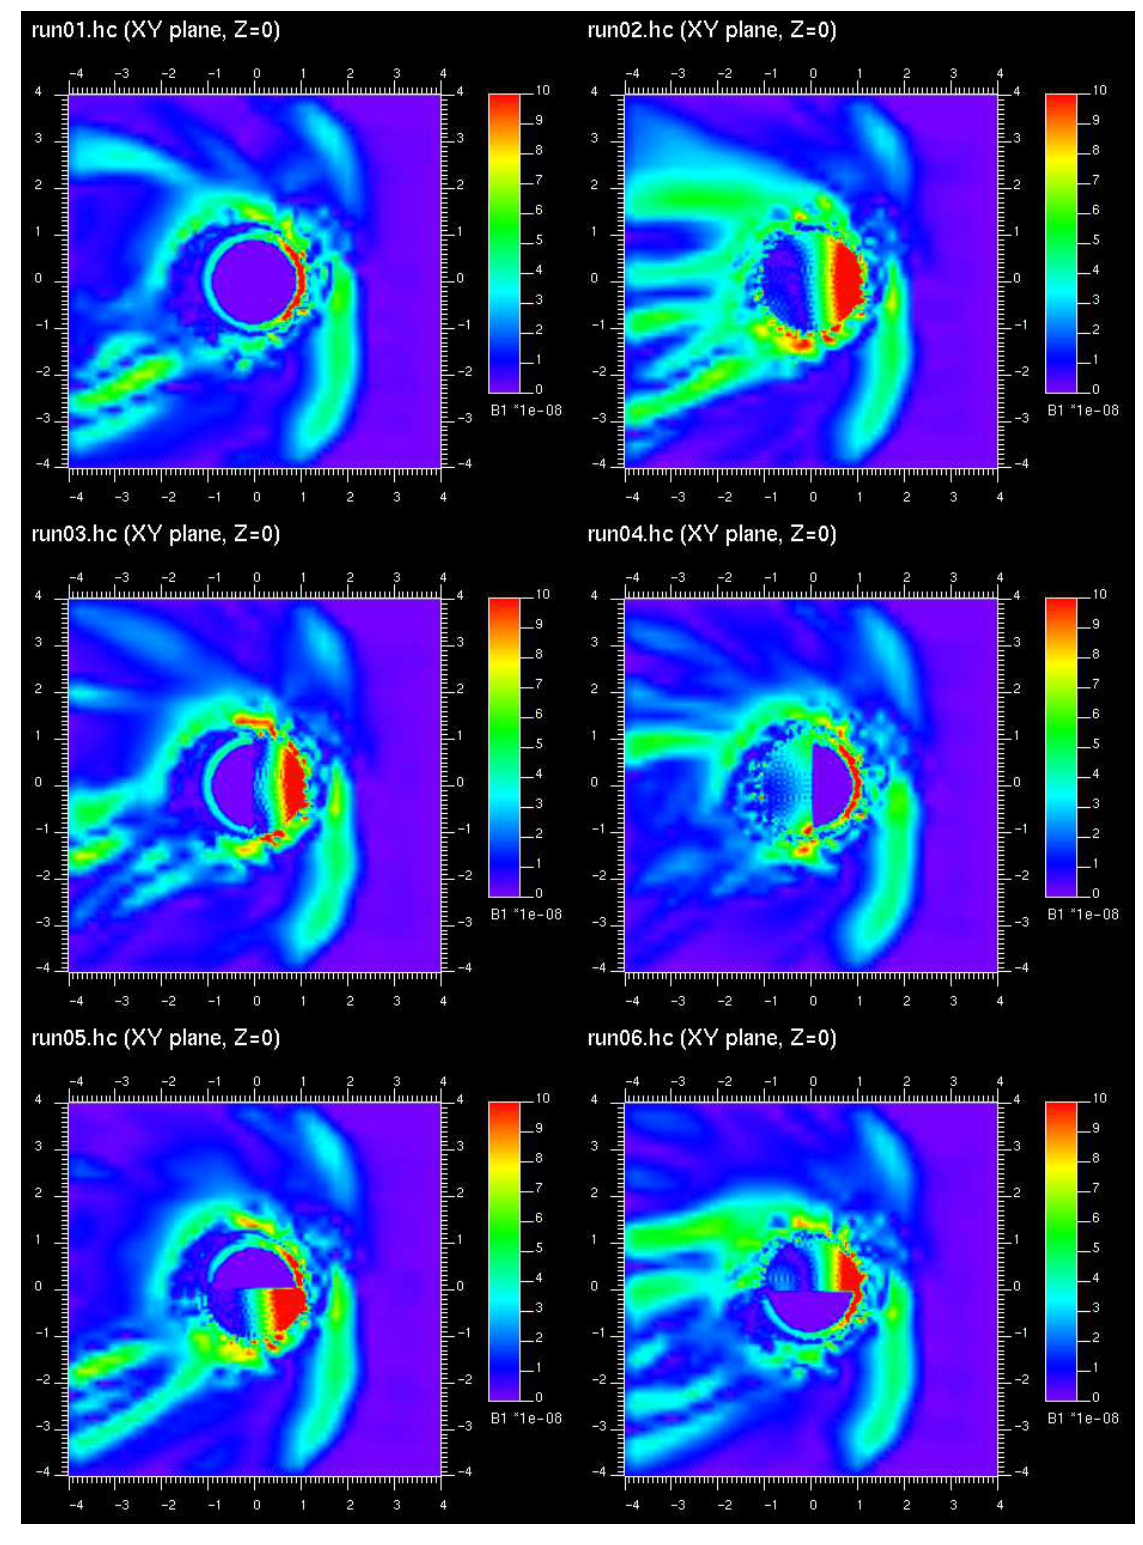
Fig. 5. The perturbation magnetic field B 1 =| B − B dip | in the XY plane in all runs (for definitions of runs 1–6, see Table 1). The horizontal axis is X (Sun is to the right) and vertical is Y (growing from dawnside toward duskside). The Z axis points out of the